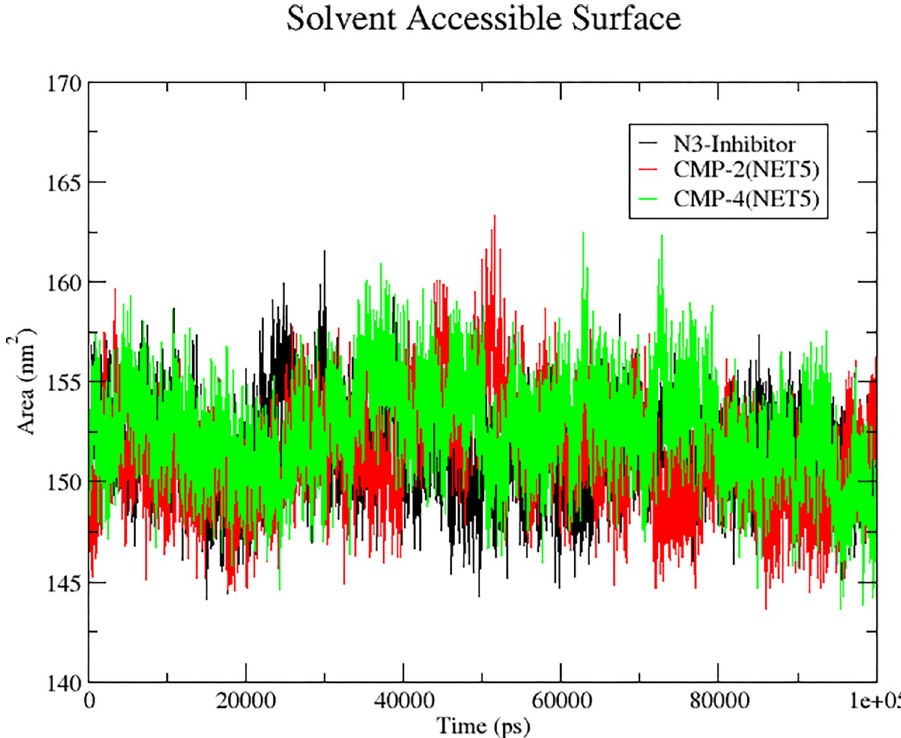
Fig 8. Solvent accessible surface area (SASA) of protein in bound state with CMP2 (NET5) , CMP4 (NET5) and reference ligand N3 over the period of 100 ns MD simulation.